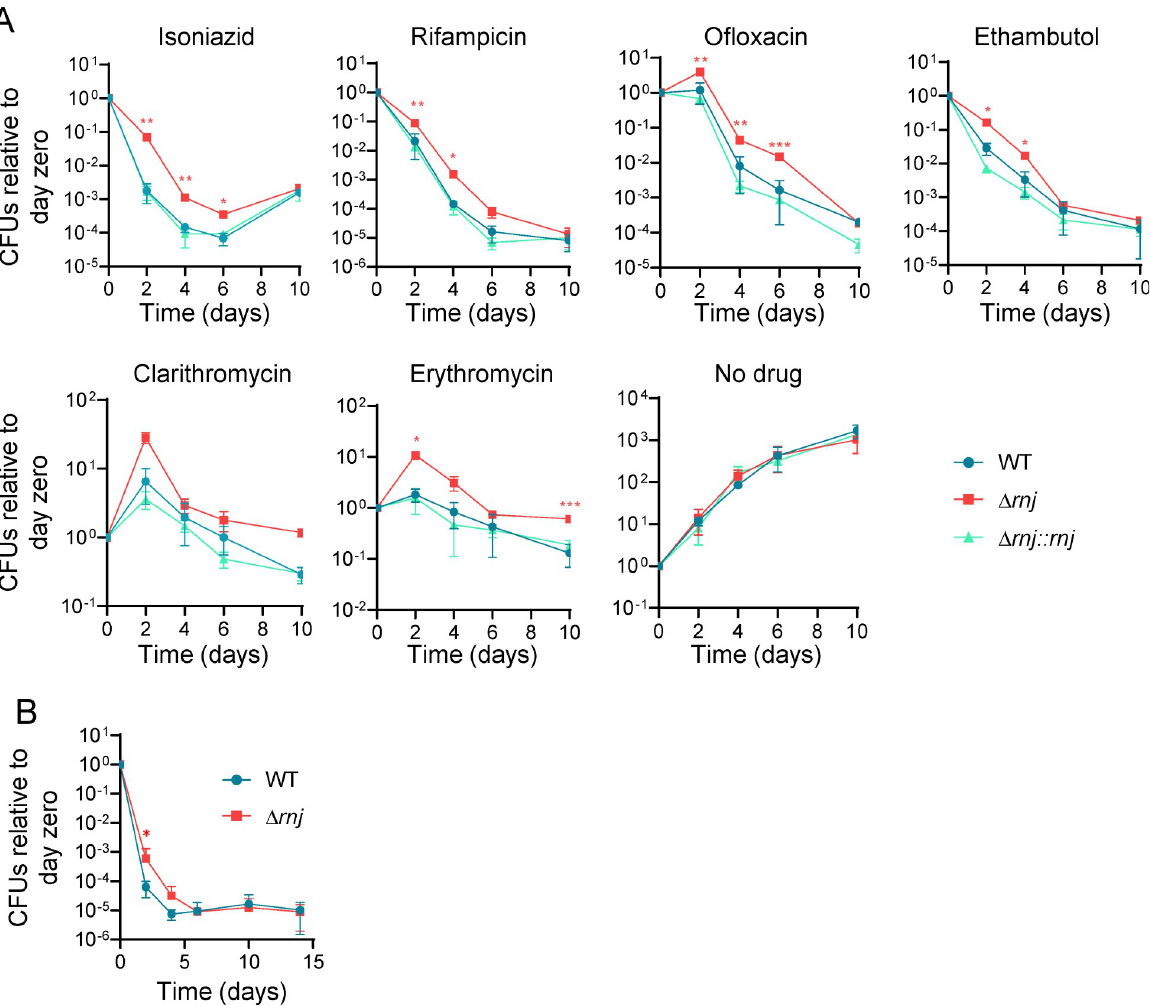
Fig 2. Loss of RNase J increases tolerance to several drugs. A. Time-kill curves in presence of the indicated drugs. The concentrations used were: 0.6 μ g/mL RIF, 2.4 μ g/mL INH, 2.5 μ g/mL CLA, 1 μ g/mL OFX, 2 μ g/mL EMB, or 500 μ g/mL ERY. B. Time-kill curves in presence of lethal concentrations of both INH (2.4 μ g/mL) and OFX (2 μ g/mL). Both experiments were performed using Mtb mc 2 6230 strains. � p < 0.05, �� p < 0.01, ��� p < 0.001 two-way ANOVA for comparisons of Δ rnj to WT. FDR 0.05 (Benjamini and Hochberg). Curves are representative of at least two independent